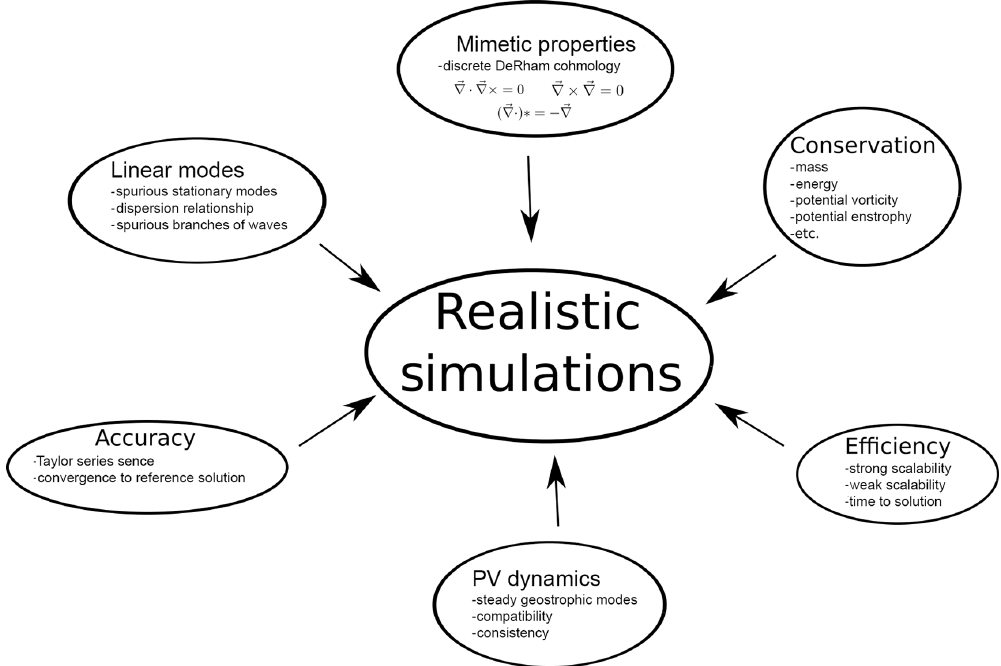
Figure 1. A diagram of some desirable model properties for the shallow water equations, organized thematically into groups. Similar con- siderations apply for the Euler, hydrostatic primitive, and other equation sets used in atmospheric models. There is vigorous discussion in the literature and between model designers about the importance of various properties for different applications (such as weather forecasting or long-term climate prediction). The schemes presented here satisfy all of these properties, with the exception of accuracy. There are additional desirable model properties, such as consistent physics–dynamics coupling, compatible and accurate tracer advection, and tractable treatment of acoustic waves that are not